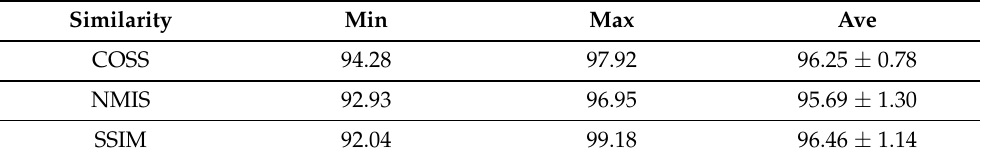
Table 7. Training Scenario I: recognition results of gradual domain adaptation recognition framework with pseudo-label denoising using different similarities (%).